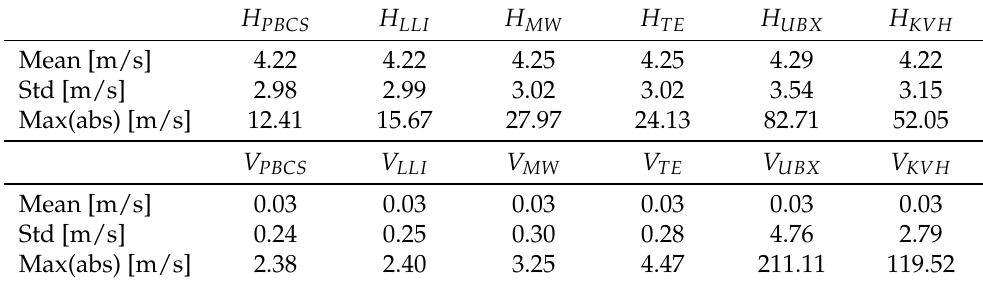
Table 12. Horizontal and vertical velocity statistics—Case Study